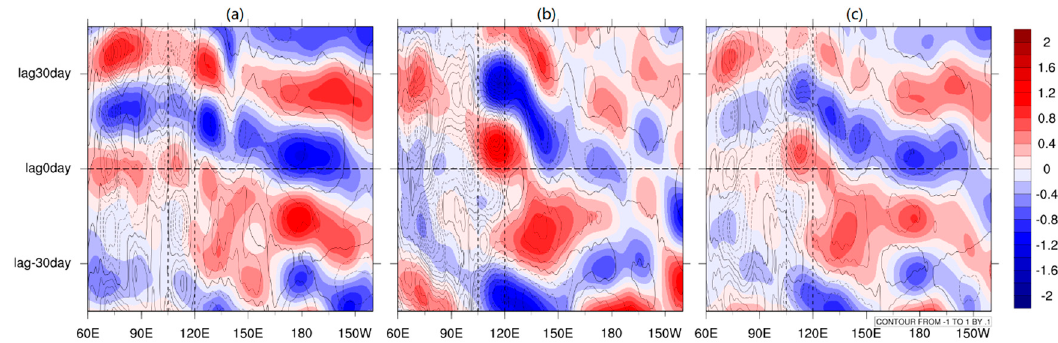
Figure 4. Same as Figure 3, but for 30-to-90-day intra-seasonal variability with doubled time scales for the ordinate. EHW events persisting less than 15 days ( a ), longer than 15 days ( b ) and ( c ) all EHW events